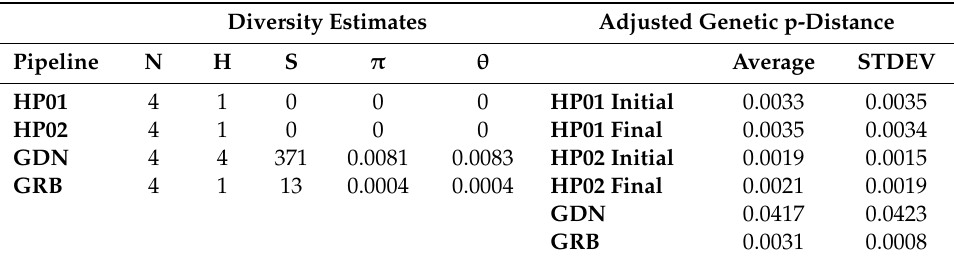
Table 6. Comparison of the e ff ect of consensus generation on estimated genetic diversity and adjusted genetic p-distance to the reference sequence across the empirical SARS-CoV-2